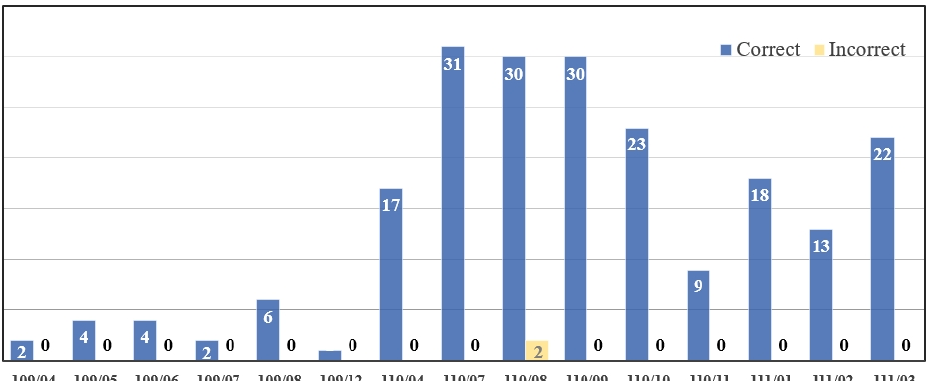
Figure 19. 8 April 2020–March 2022 excavation verification statistics.